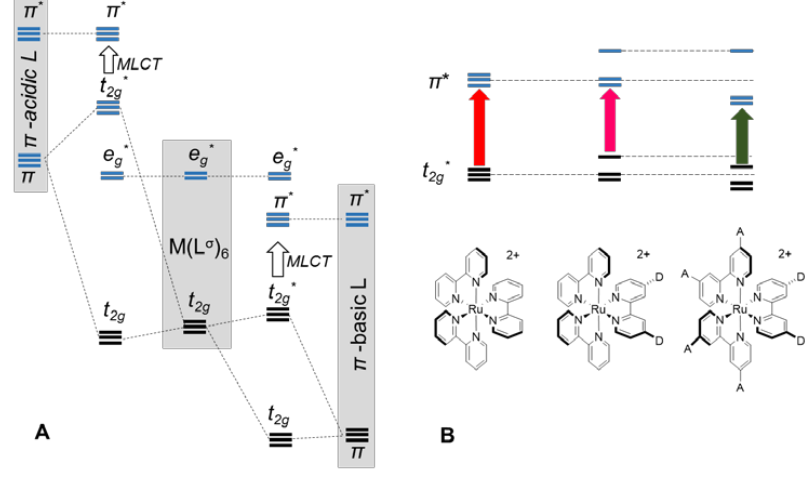
Figure 4. ( A ) An interaction of π -acidic and π -basic ligand orbitals with metal-based orbitals formed as a result of the interaction with six σ -ligands (vide supra Figure 3). ( B ) The effect of π -donor and π -acceptor substituents on the molecular orbital energies in heteroleptic ruthenium(II) complexes. D and A stand for π -donating and accepting substituents. The black and blue bars represent doubly filled and empty orbitals, respectively.